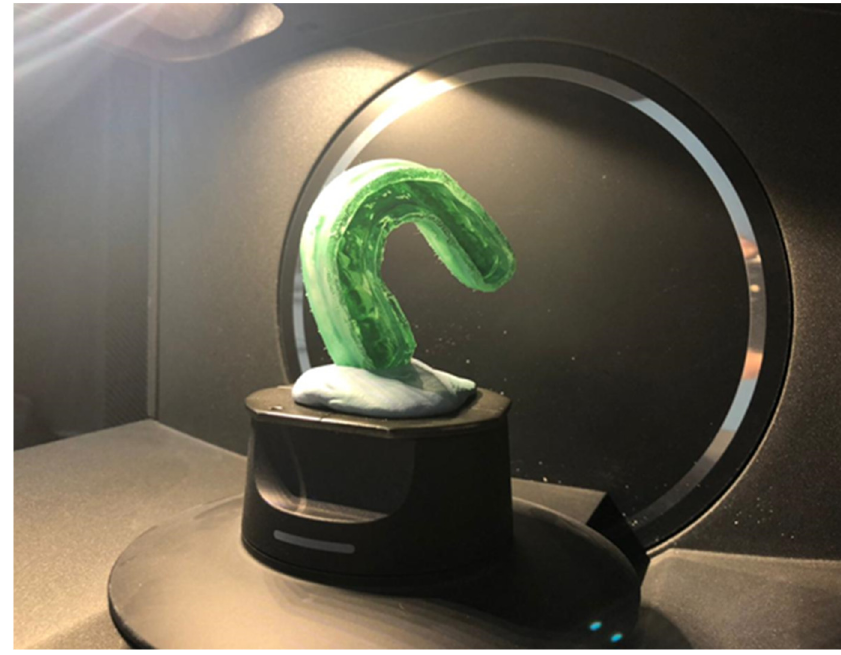
Figure 1. Hybrid mouthguard device positioned in the desktop scanner.